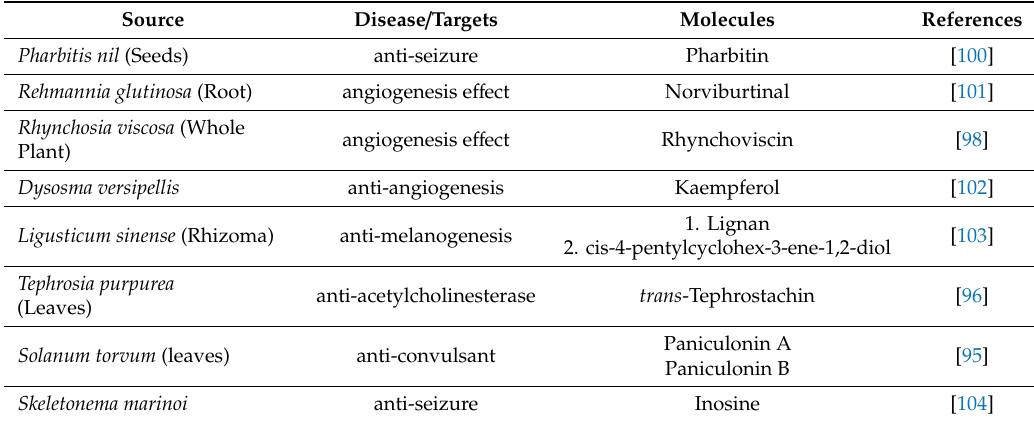
Table 2. Zebrafish bioassay-guided isolation and structurally characterized natural